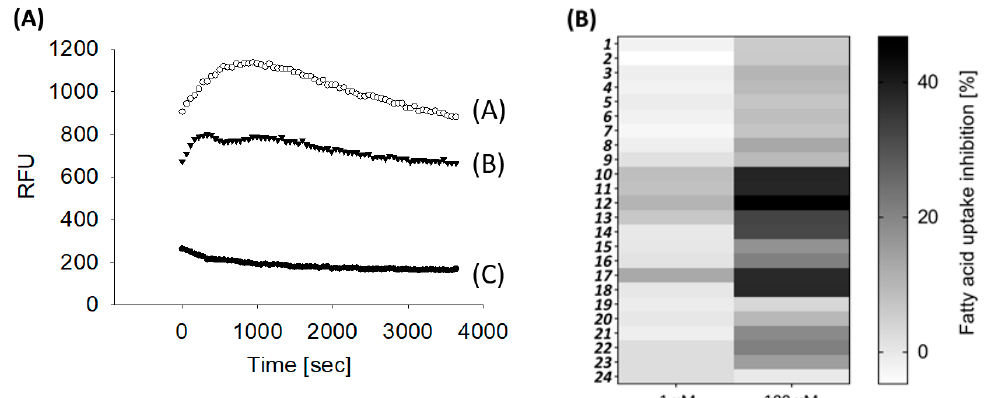
Figure 3. Schematic overview of the general synthesis to homovanillic esters D .